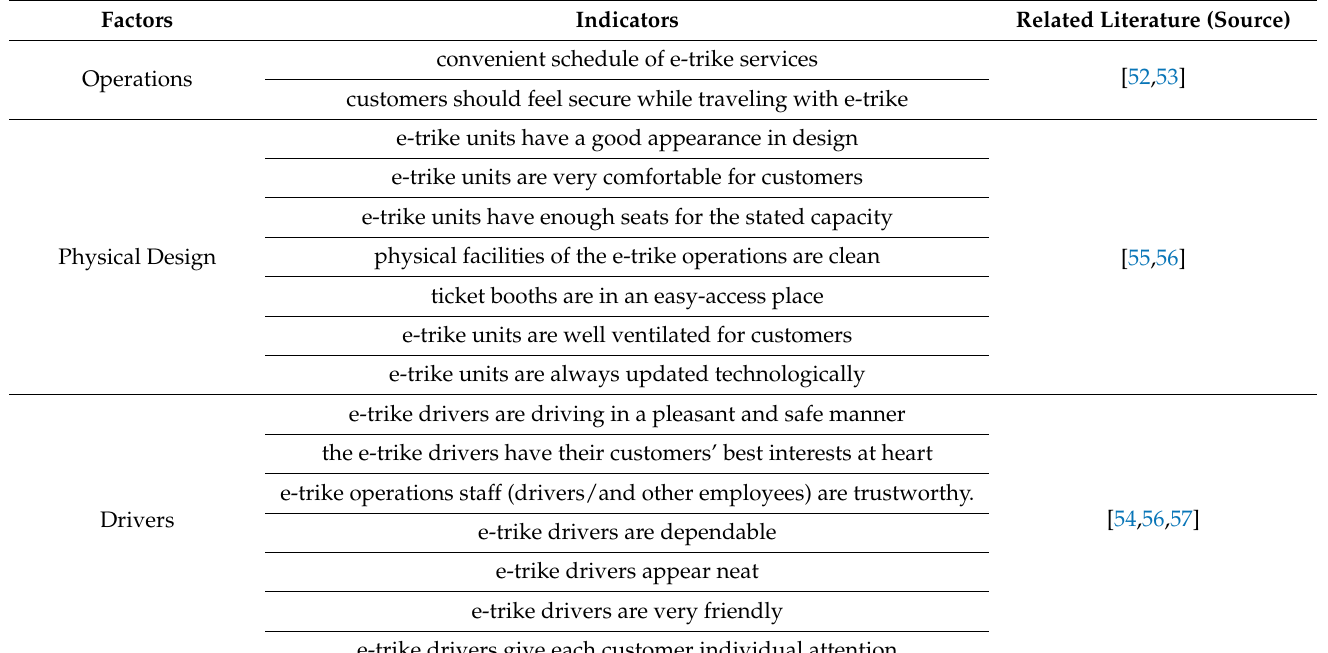
Table 2. Summary of indicators for service quality